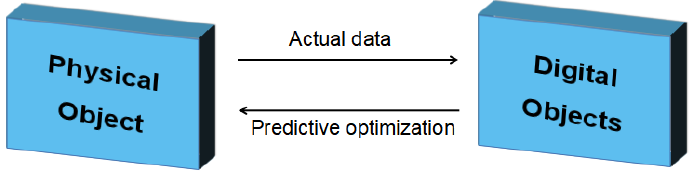
Figure 1. Digital twin conceptual model.